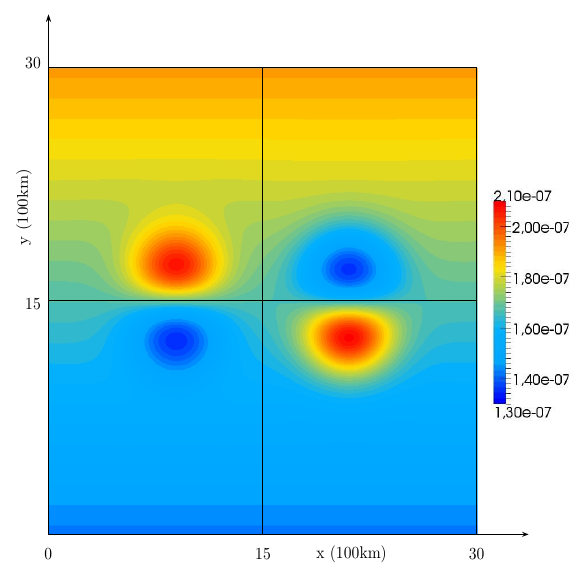
Fig. 1. Initial potential vorticity (in ( ms ) − 1 ) of the upper layer. The initial condition is purely large-scale. The two dipoles on the β − plane are clearly visible.